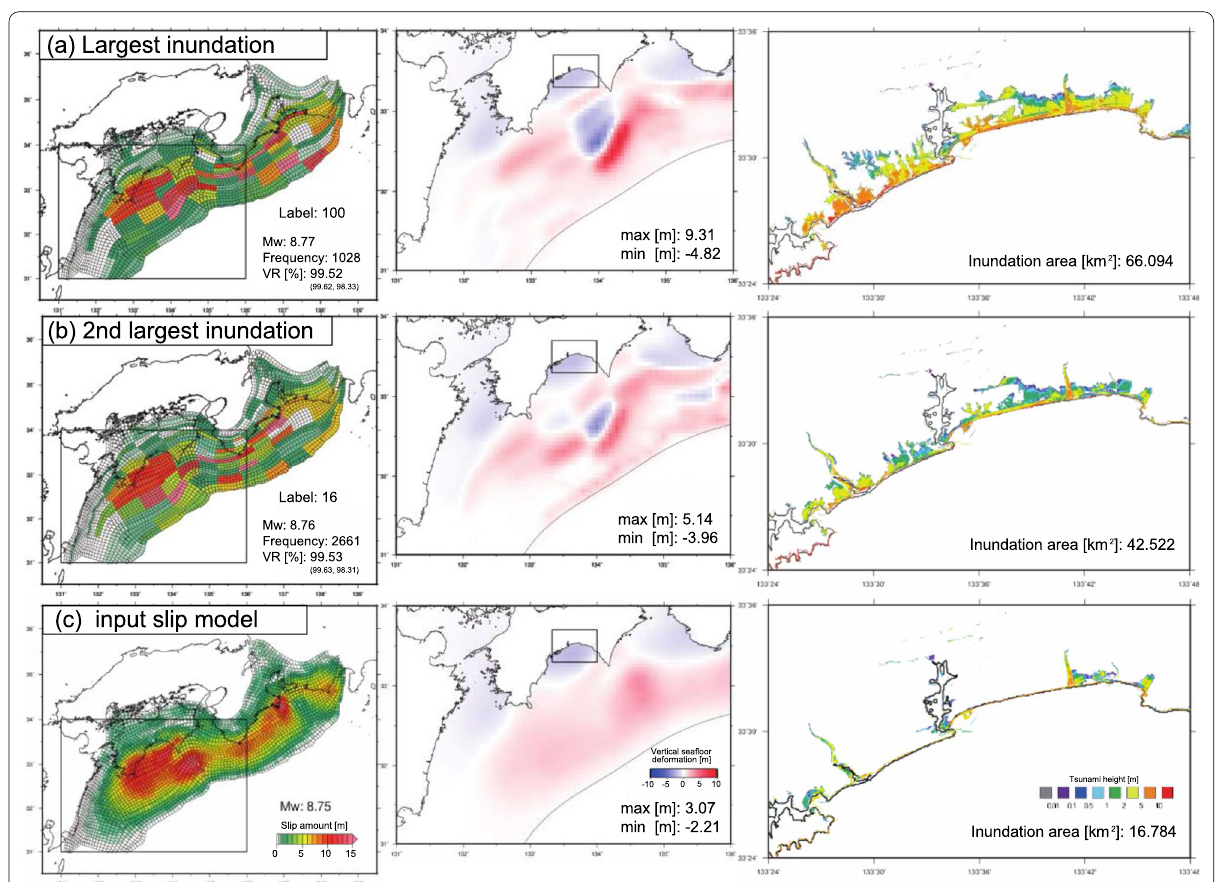
Fig. 8 Slip distribution, seafloor vertical deformation (initial wave field), and tsunami inundation scenarios ( K 100). a Case of flooding across = the largest area. b Case of flooding across the second largest area. c The case of the input slip model that was used to generate the synthetic observations (Fig. 1). Left: Slip distribution (tsunami scenario), for which the slip amount of each subfault is the median of the cluster. Inserted values indicate the Mw and frequency of the cluster and variance reduction (VR) with horizontal and vertical components. Black rectangles indicate the area of seafloor vertical deformation shown in the middle panels. Middle: seafloor vertical deformation calculated from the left slip distribution using Okada (1992). Inserted values indicate the maximum and minimum vertical deformation. Black rectangles indicate the area shown in the tsunami inundation map to the right. Right: Tsunami inundation, where colors indicate tsunami height. Inserted values indicate the inundation